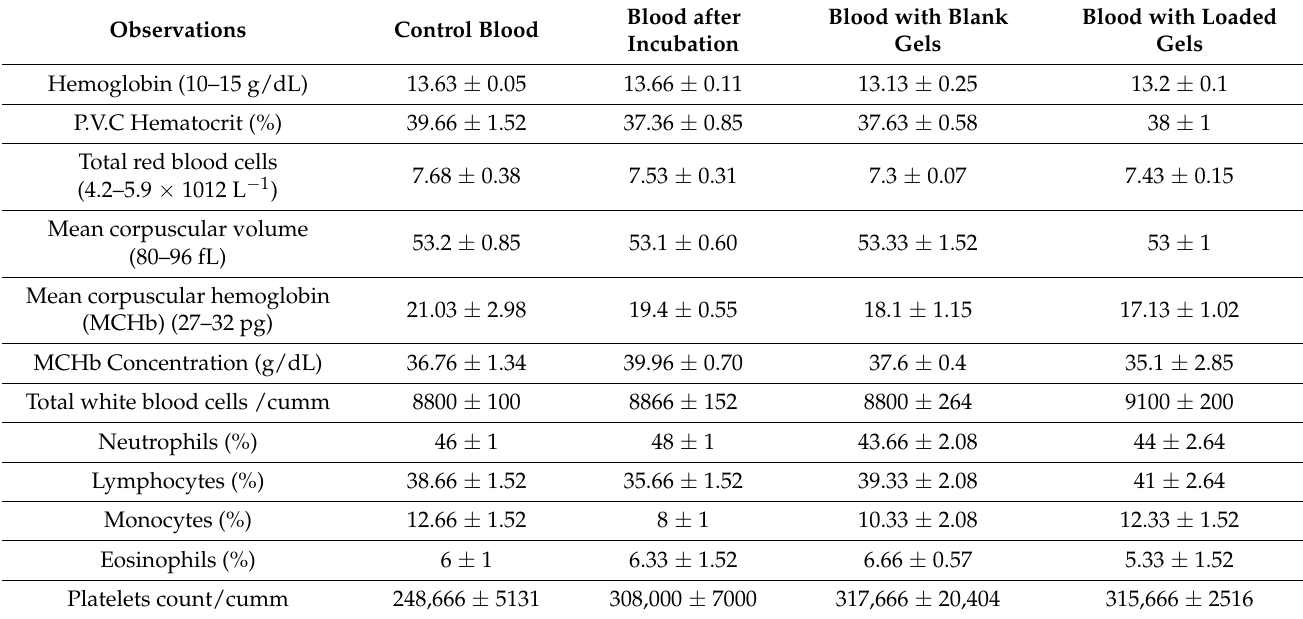
Table 4. Biochemical blood analysis.